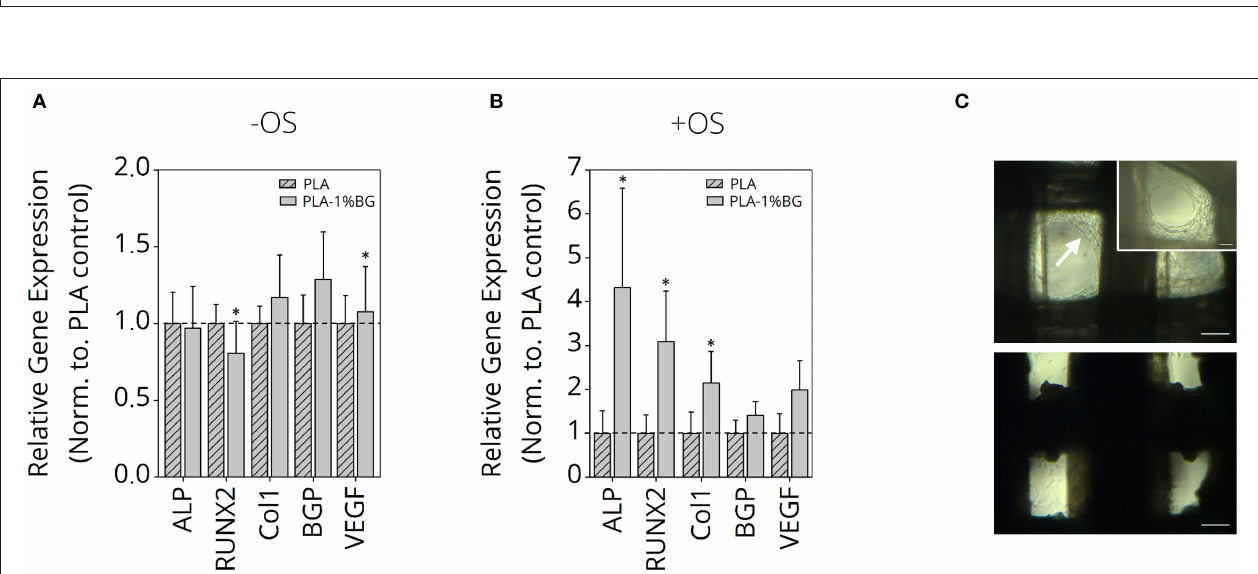
FIGURE 8 | Gene expression study of human ASC on PLA-1% BG scaffolds. Relative gene expression of Col1, VEGF, BGP, RUNX2, and ALP in human ASC cultured for 35 days on 3D printed 1% BG containing PLA scaffolds normalized to PLA scaffolds in (A) nonosteogenic and (B) osteogenic differentiation medium. Data is reported as mean ± s.e.m ( n = 4). ANOVA with post-hoc Tukey -HSD test; * p ≤ 0.05. (C) Light microscopy images of ASC after 35 days cultured in non-osteogenic (top) and osteogenic (bottom) medium. The white arrow indicates higher cell growth observed inside scaffold pores for ASC cultured in nonosteogenic medium in comparison to + OS scaffolds, indicative for higher proliferation on –OS scaffolds. Scale bars: 200 µ m, 100 µ m (insert, top right).